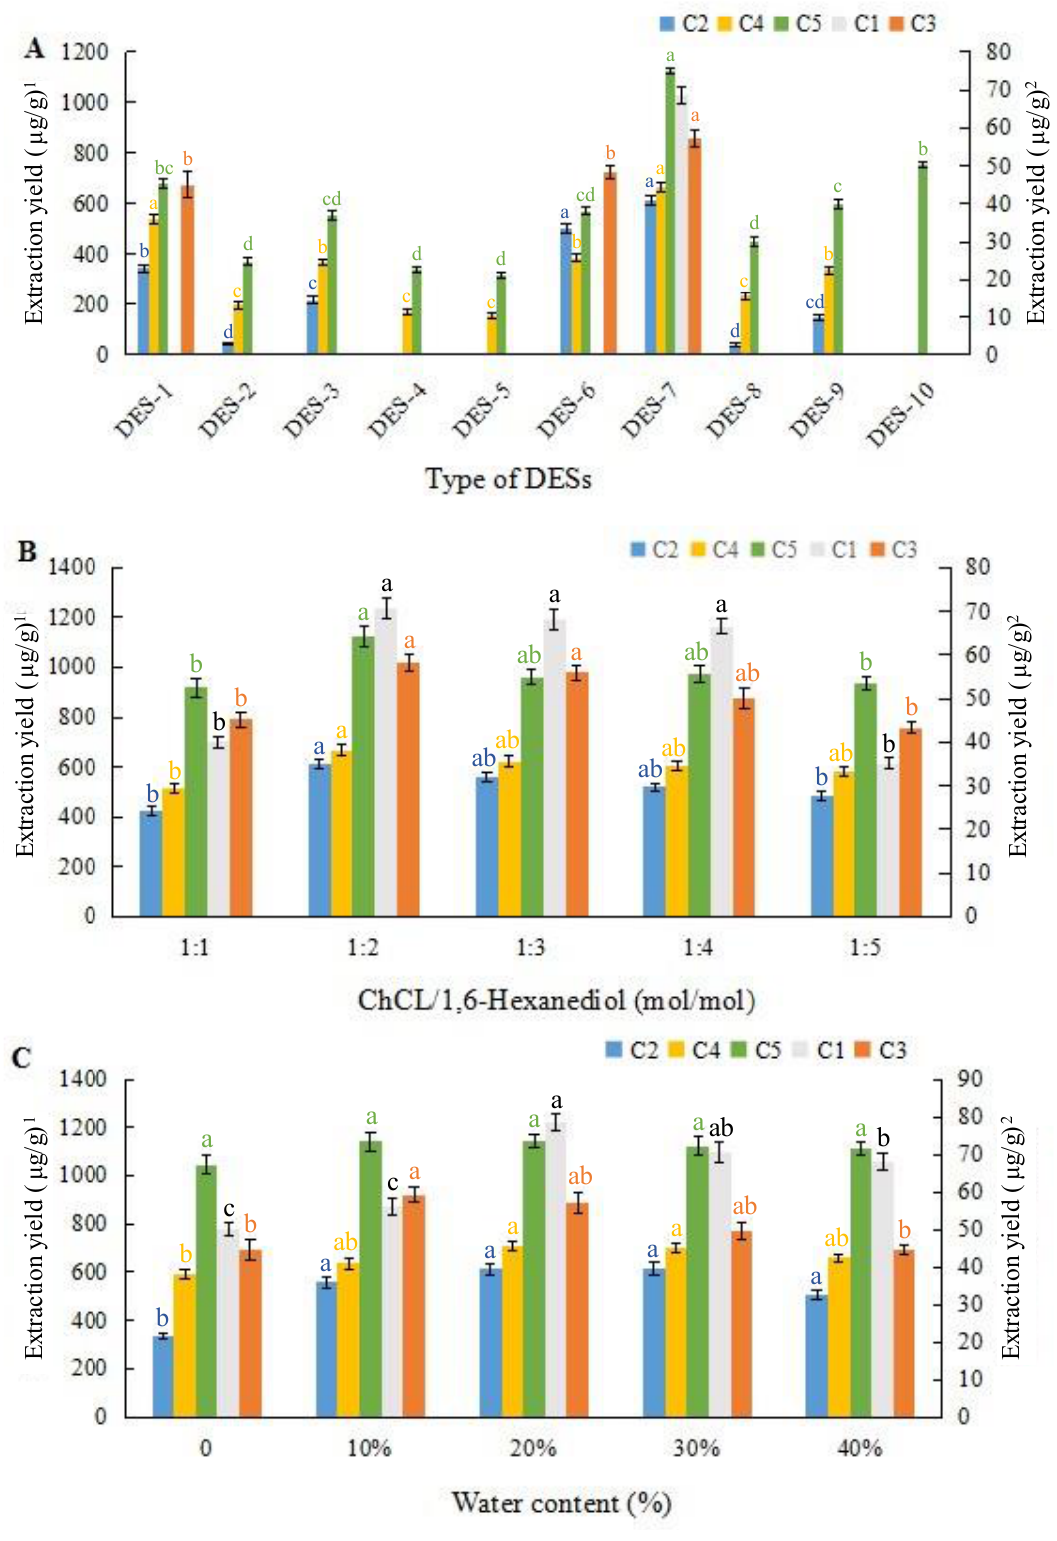
Figure 1. The effects of different DESs ( A ), choline chloride to 1,6-hexanediol ratios ( B ), and water content ( C ) in DESs on the extraction yields of the five macamideds. 1 Extraction yields of C2, C4, and C5; 2 Extraction yields of C1 and C3. Different lowercase in the columns of the same color represents a significant difference at p < 0.05.